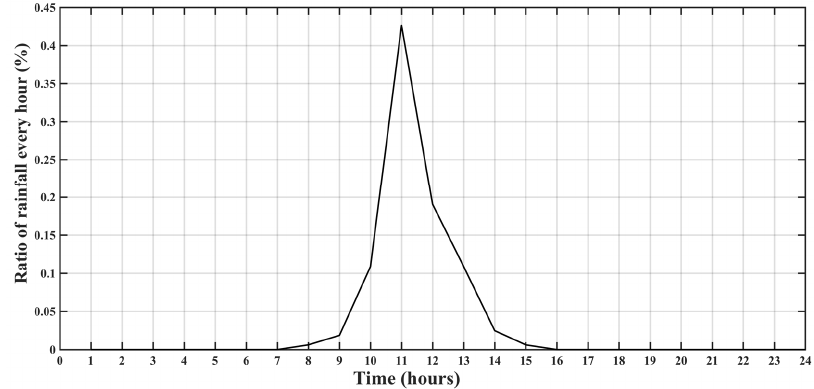
Figure 10. Design hyetograph.